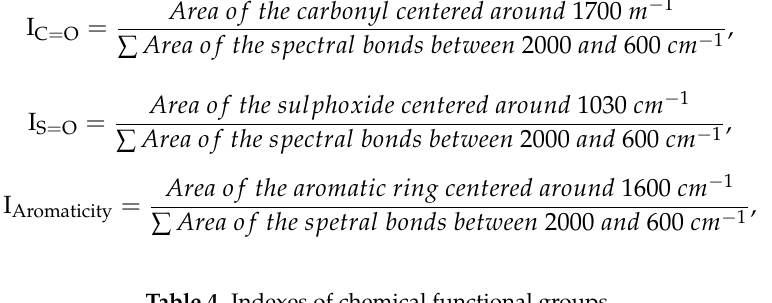
Table 4. Indexes of chemical functional groups.